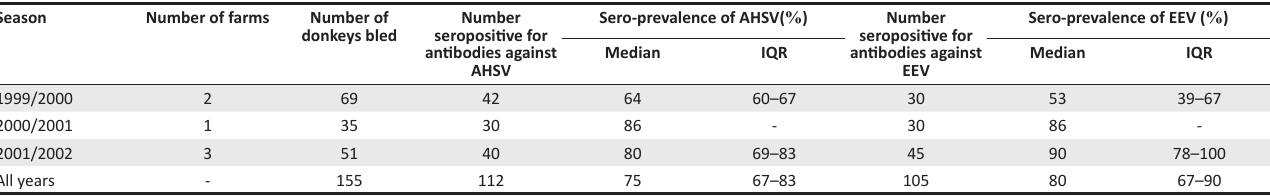
TABLE 2: The sero-prevalence of antibodies against African horse sickness virus and equine encephalosis virus in donkeys in Zimbabwe during three rainy seasons for the period 1999–2002. Season Number of farms Number of donkeys